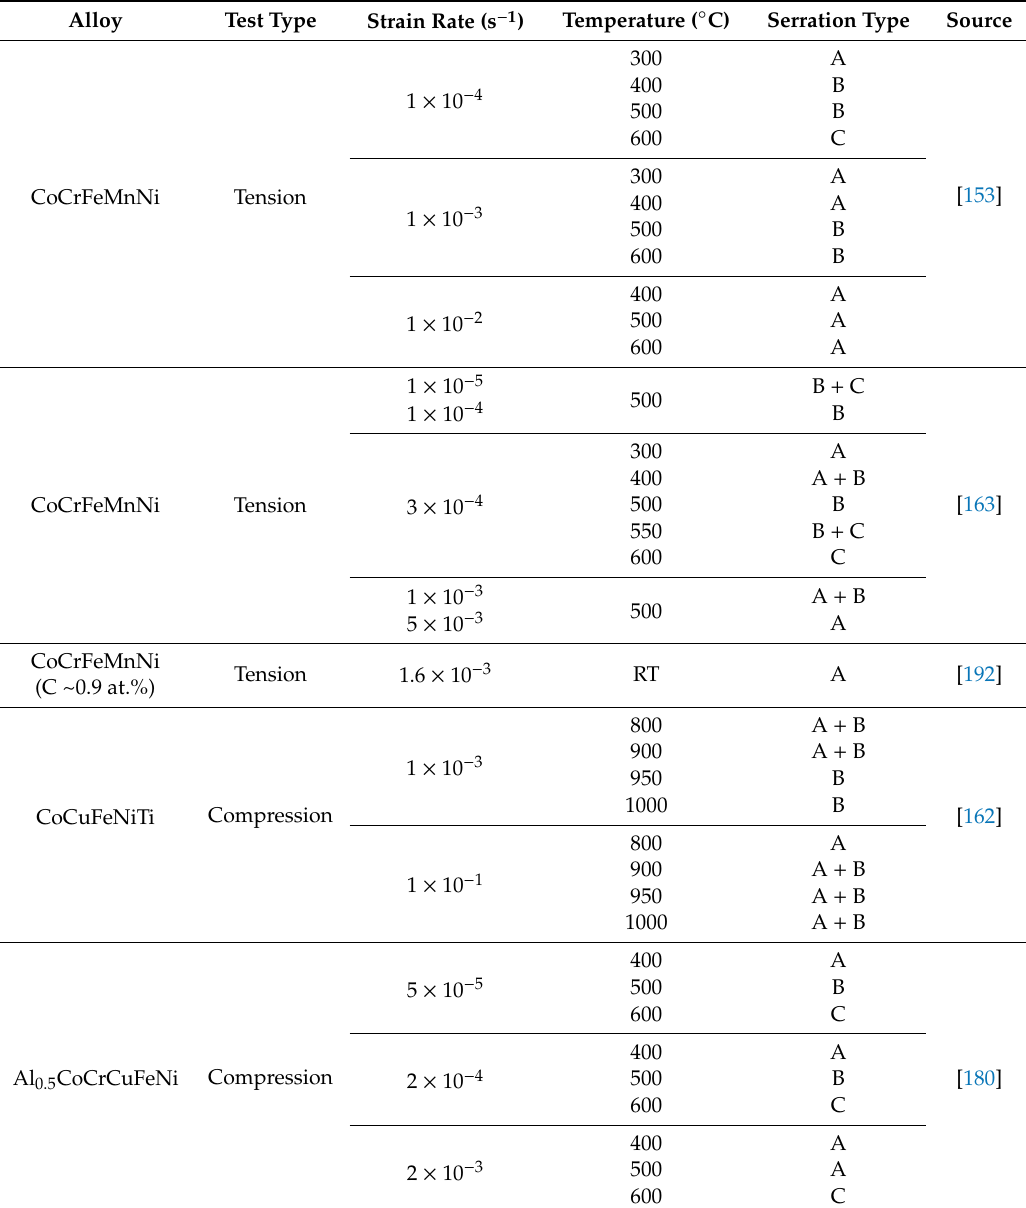
Reported serration type, as found from the literature, for Type-A, Type-B, Type-C, Type-A + Type-B, and Type-B + Type-C for di ff erent HEAs tested in a range of strain rates and temperatures. RT: room